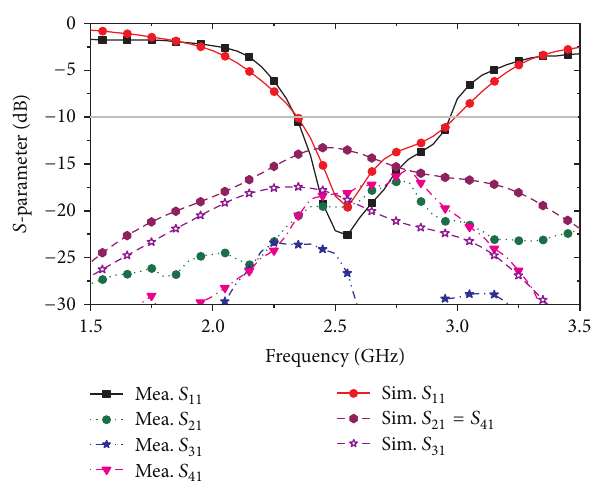
Figure 6: Simulated and measured 𝑆 -parameters of Ant. 1 design.